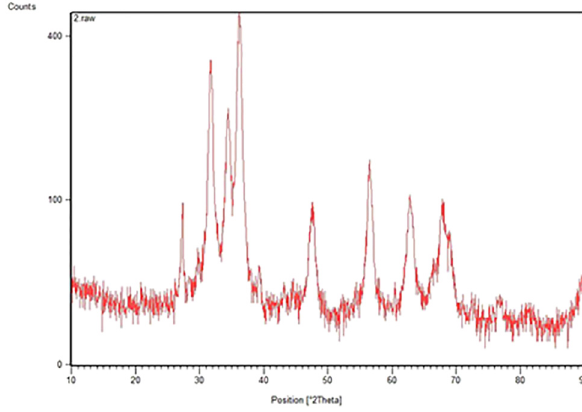
Figure 9: XRD pattern of the synthesized ZnO NPs at optimum conditions.